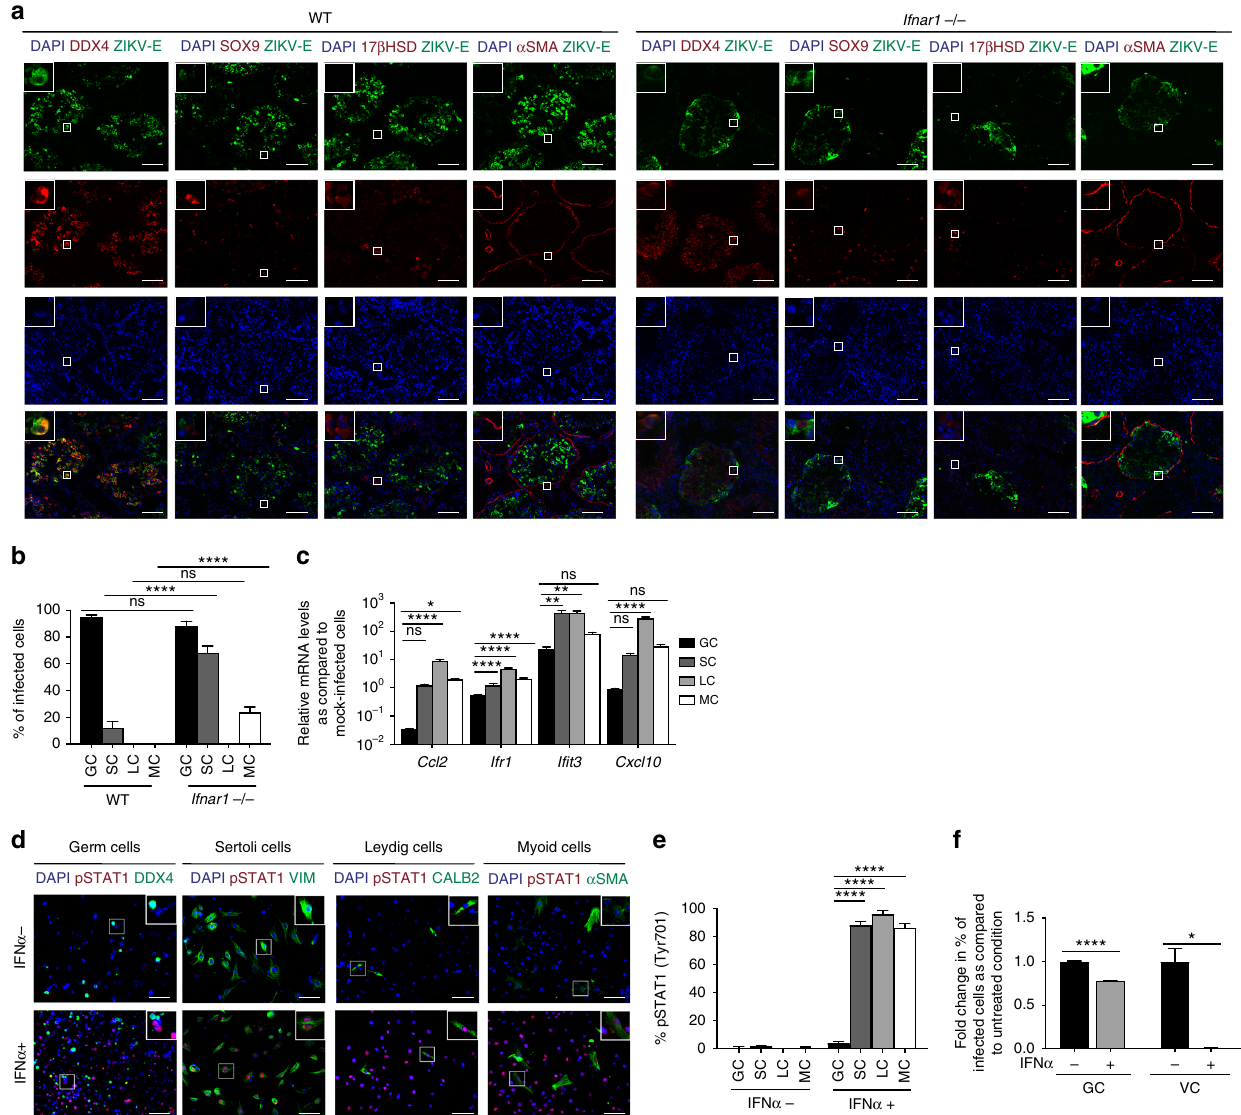
Fig. 2 Increased susceptibility to ZIKV infection in murine male GCs due to reduced IFN signaling. a , b Immunostaining ( a ) and quanti fi cation ( b ) of ZIKV- infected wild-type C57/BL6J (IFU = 1 × 10 5 ) and Ifnar1 − / − (IFU = 1 × 10 2 ) testis at 6 dpi. c Induction of ISGs in ZIKV-infected (MOI = 0.1 PFU per cell) GCs, SCs, LCs, and MCs at 72 hpi ( n = 3) measured by qRT-PCR. d , e Immunostaining (VIM for SCs and CALB2 for LCs) ( d ) and quanti fi cation ( n = 5 for